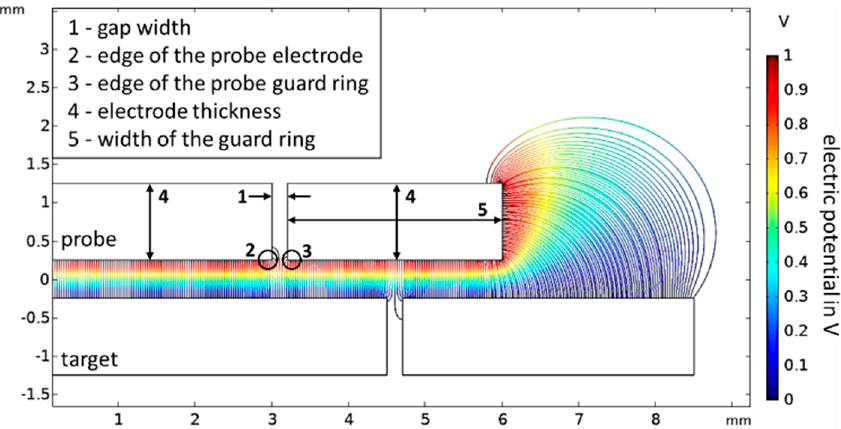
Figure 8. Presentation of the five parameters whose influence on the capacitance, the slope error, and nonlinearity are simulated. The parameters are (1) the width of the dielectric gap, (2) the edge radius of the probe electrode, (3) the edge radius of the probe guard ring, (4) the thickness of the electrodes, and (5) the width of the guard ring.